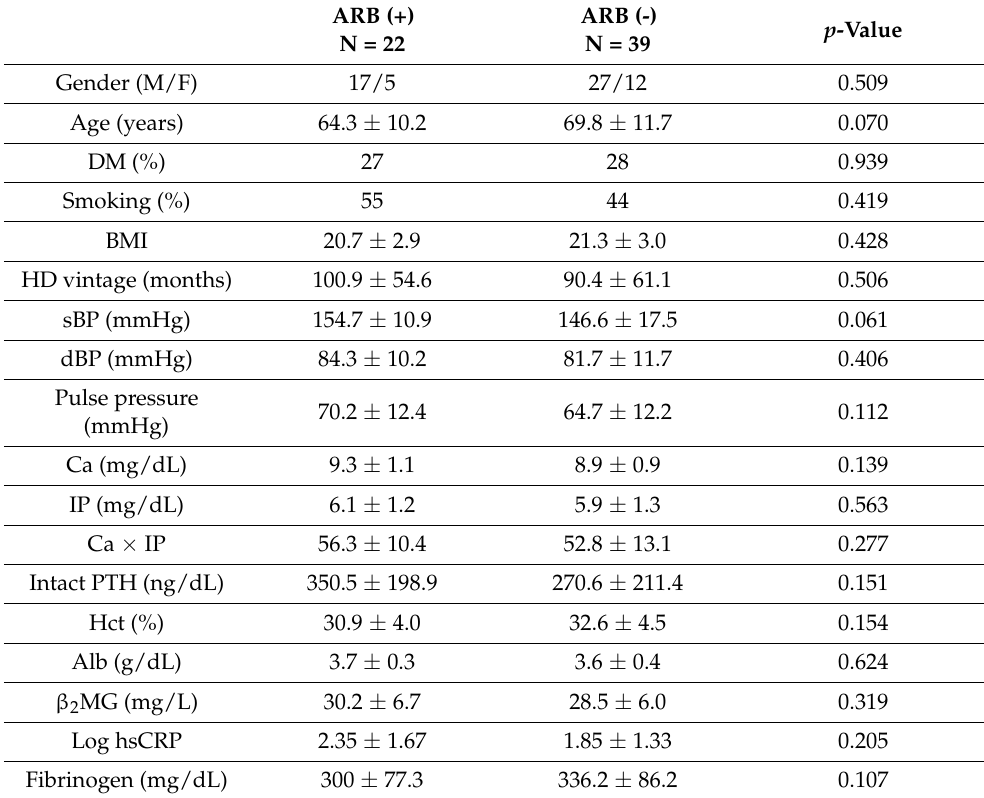
Table 2. Data according to the presence or absence of